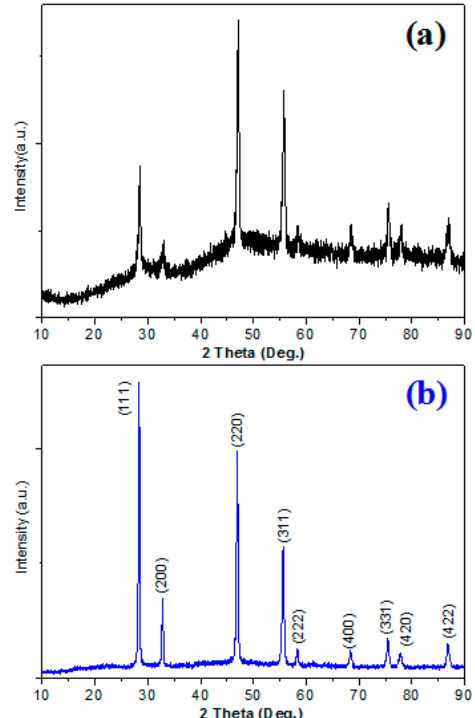
Figure 2. XRD patterns of ( a ) NaYF 4 host, and ( b ) NYF:Yb 3+ ,Er 3+ (20/2 mol%) samples using 1,2-ethanediol as solvent.